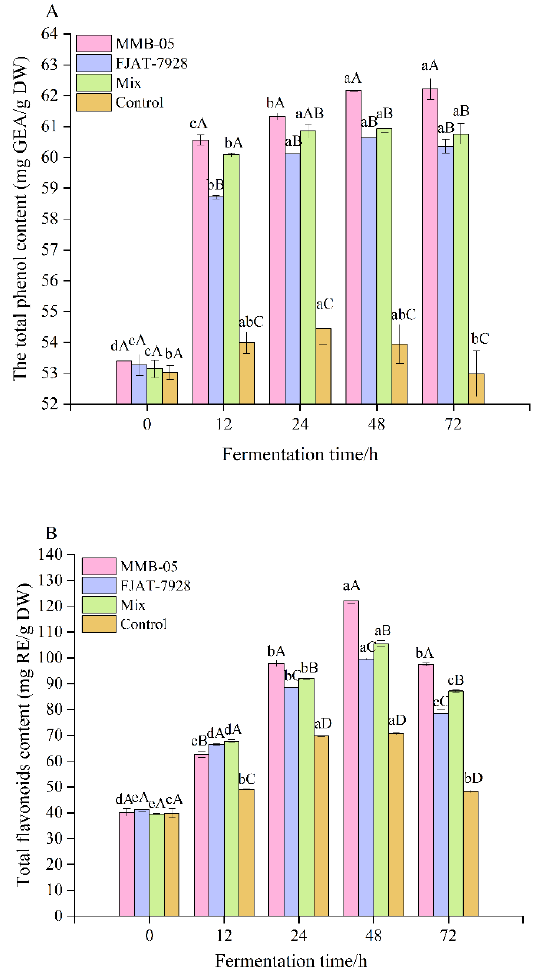
Figure 5. Changes in total phenol ( A ) and total flavonoids ( B ) contents during LAB stains fermentation of P. yezoensis sauce. Note: abcd represents the significant difference between groups (different fermentation time in the same group). ABCD represents the significant difference between the same fermentation time of different groups ( p < 0.05).